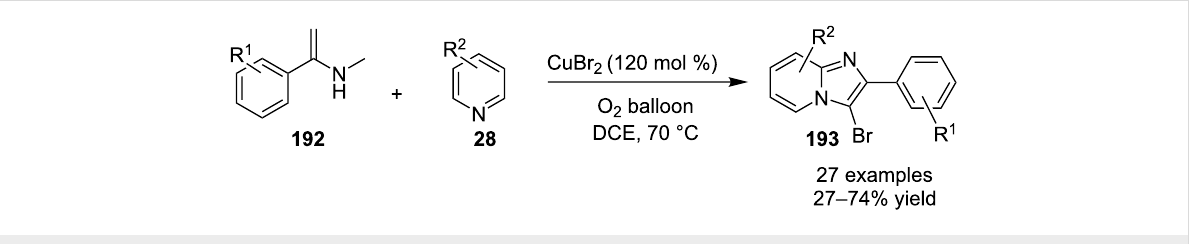
Scheme 68: CuBr 2 -mediated one-pot two-component oxidative coupling reaction.